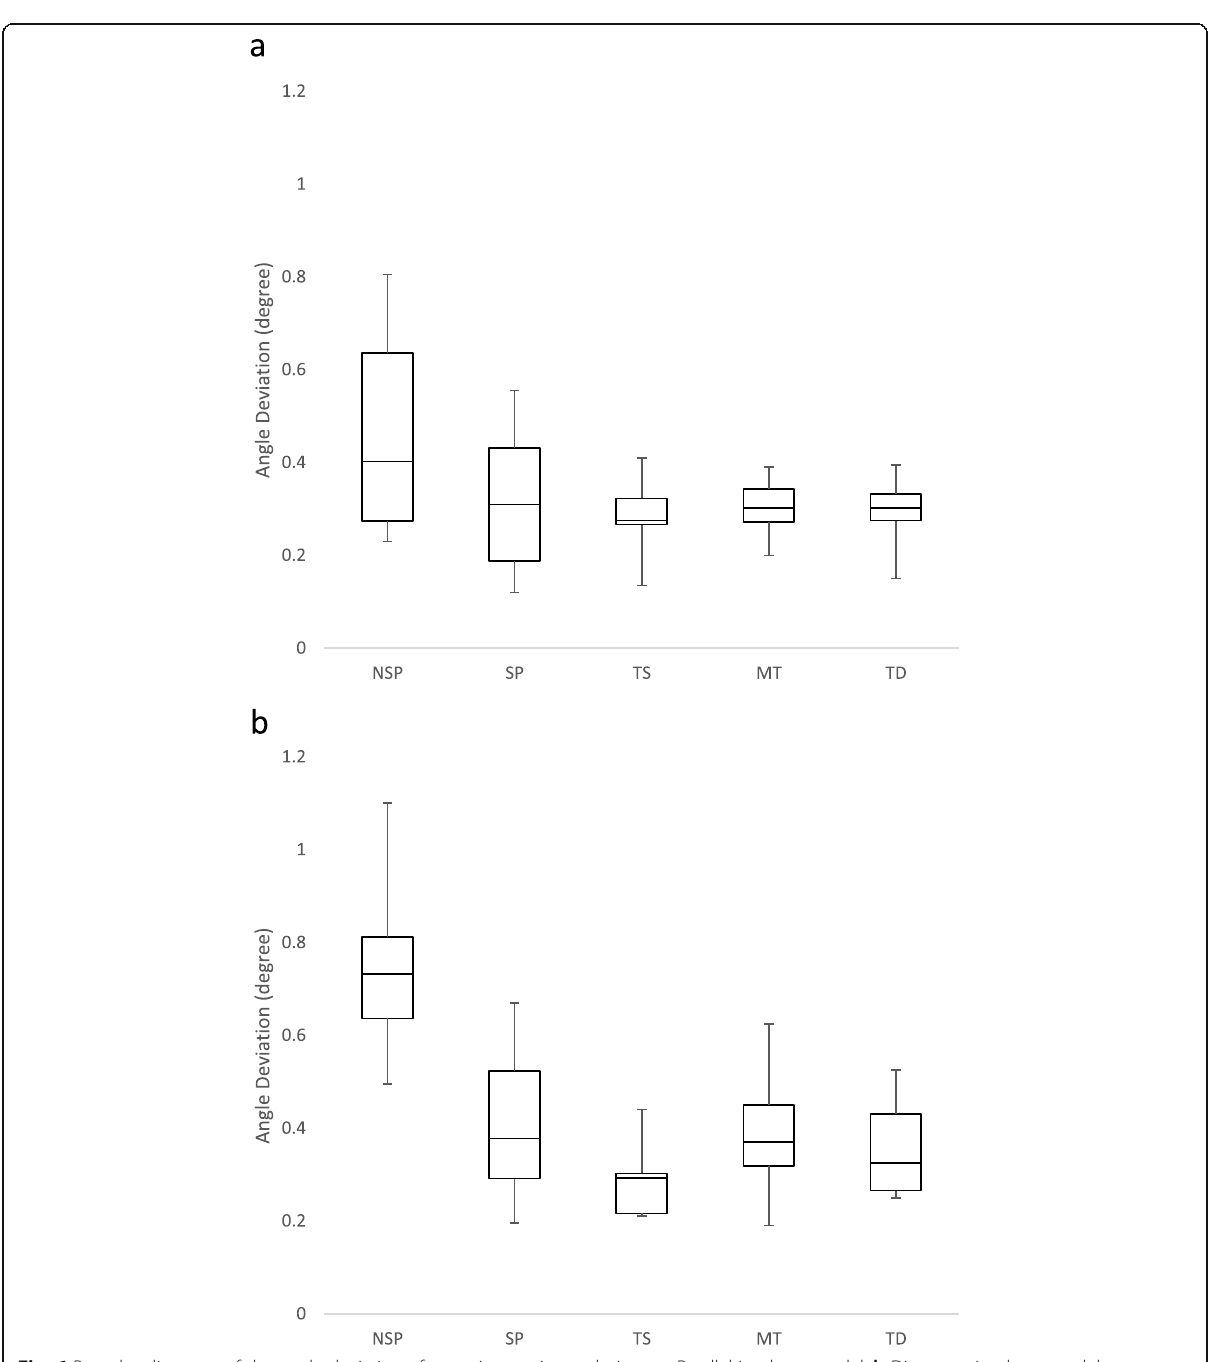
Fig. 6 Box plot diagrams of the angle deviation of every impression technique. a Parallel implants model. b Divergent implants